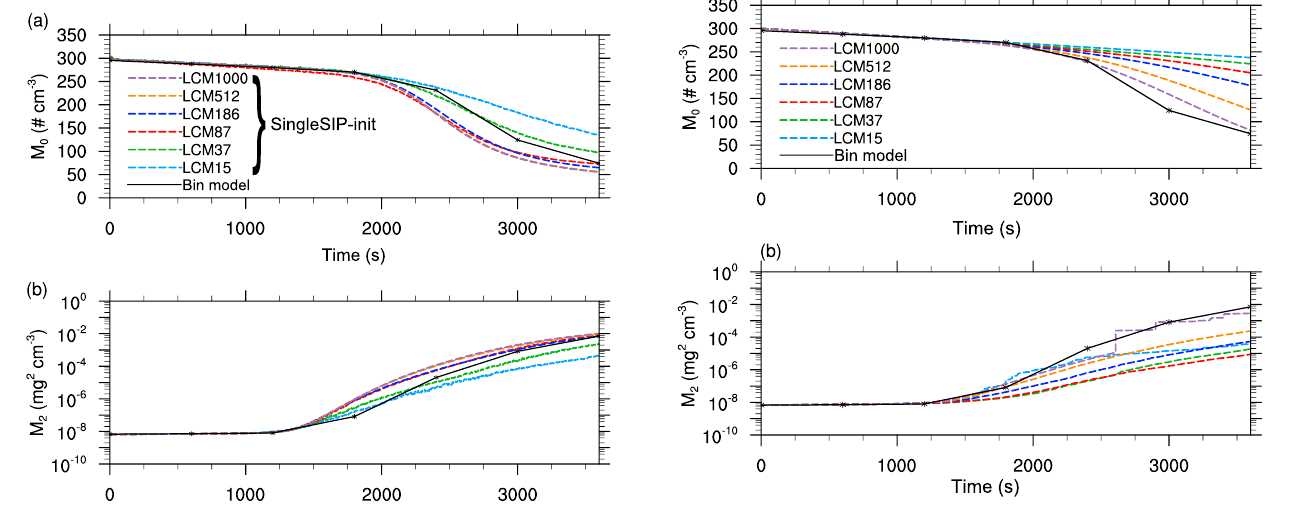
Figure 4. Moments of the mass density distribution as a function of time obtained from the single-box simulations. The black solid line denotes the solution of Wang et al. (2007). The colored dashed curves show the solution of the LCM with different numbers of su- perdroplets per grid